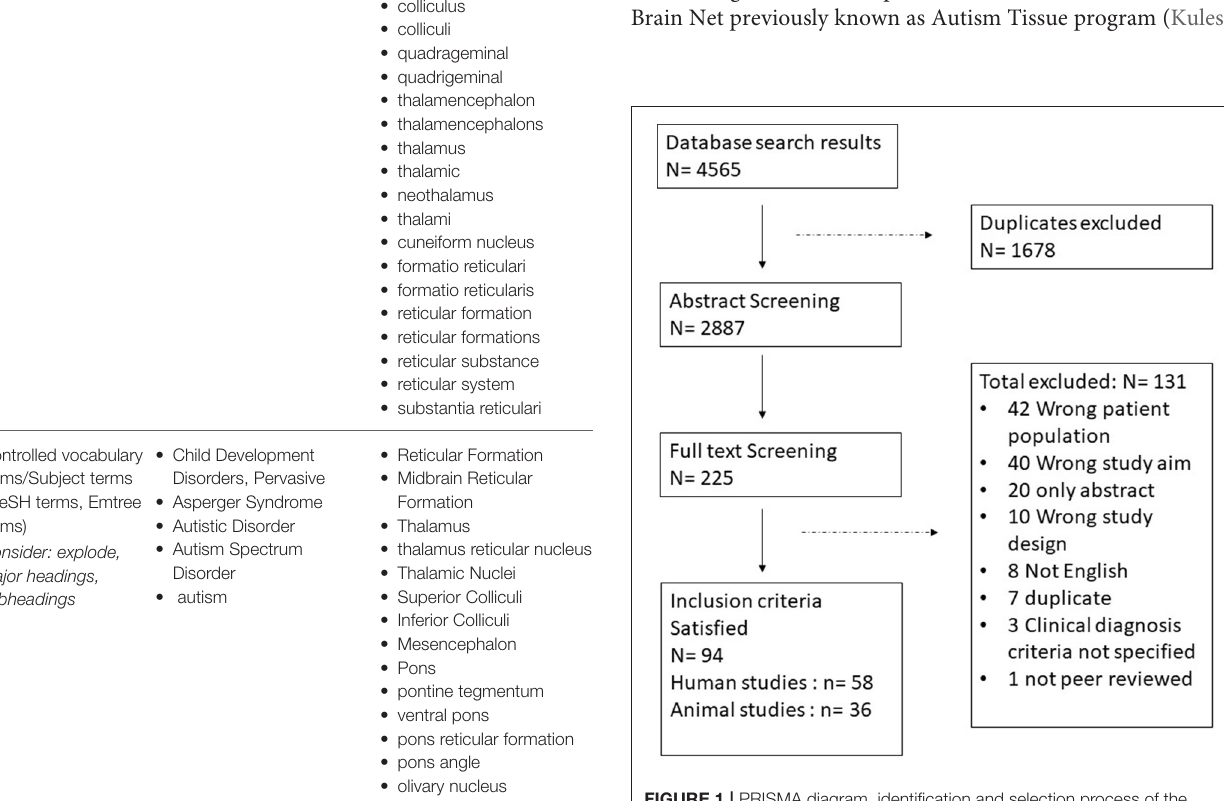
FIGURE 1 | PRISMA diagram, identification and selection process of the